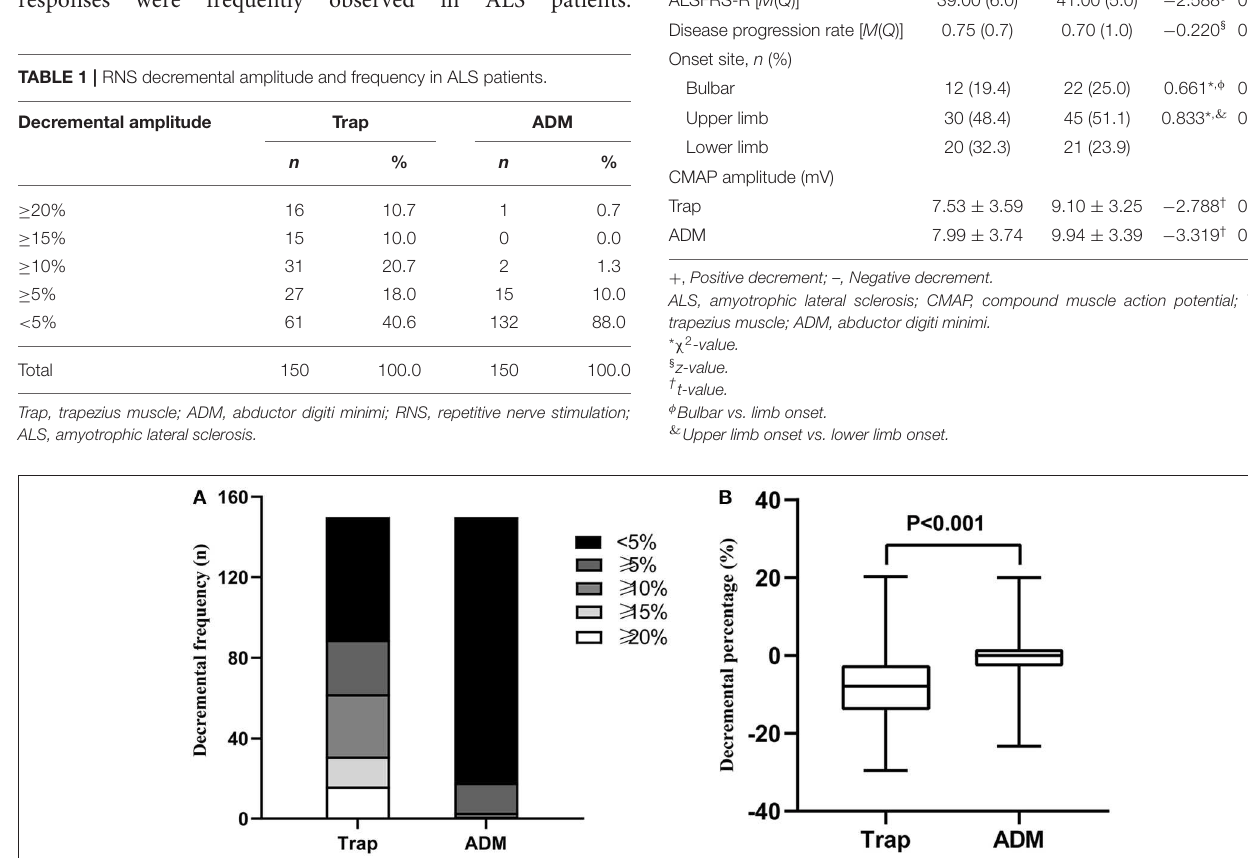
FIGURE 1 | (A) Decremental frequency in the Trap and ADM of ALS patients. (B) Decremental percentage in the Trap and ADM of ALS patients. Trap, trapezius muscle; ADM, abductor digiti minimi.